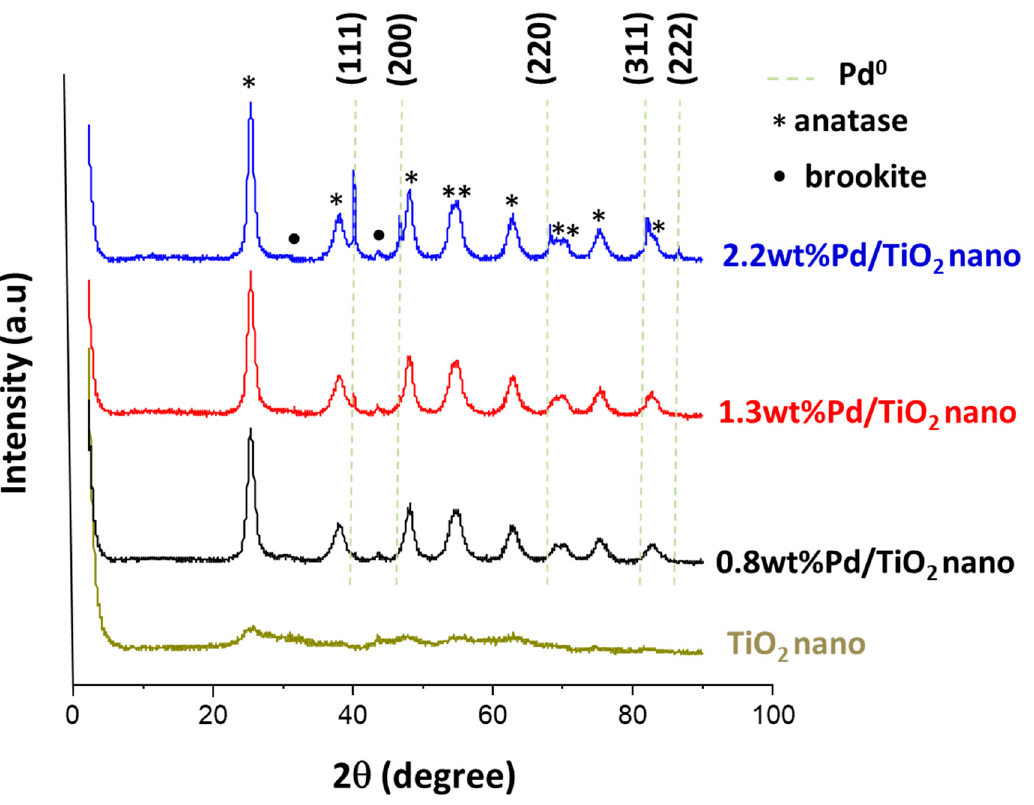
Figure 4. X-ray diffraction patterns for pure TiO 2 nano and different TiO 2 nano-supported Pd catalysts.